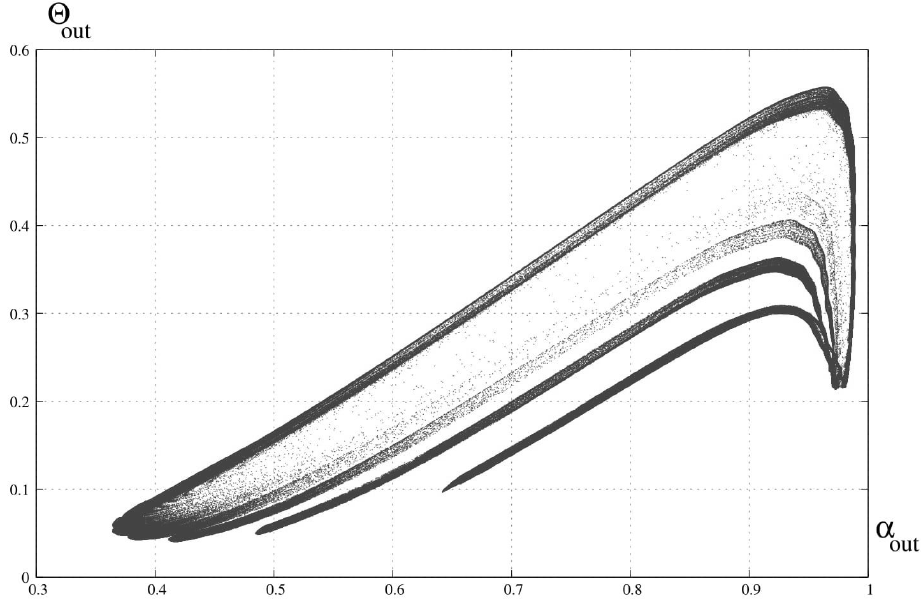
Figure 6. Poincare cross-section for Da = 0.13 and τ r =